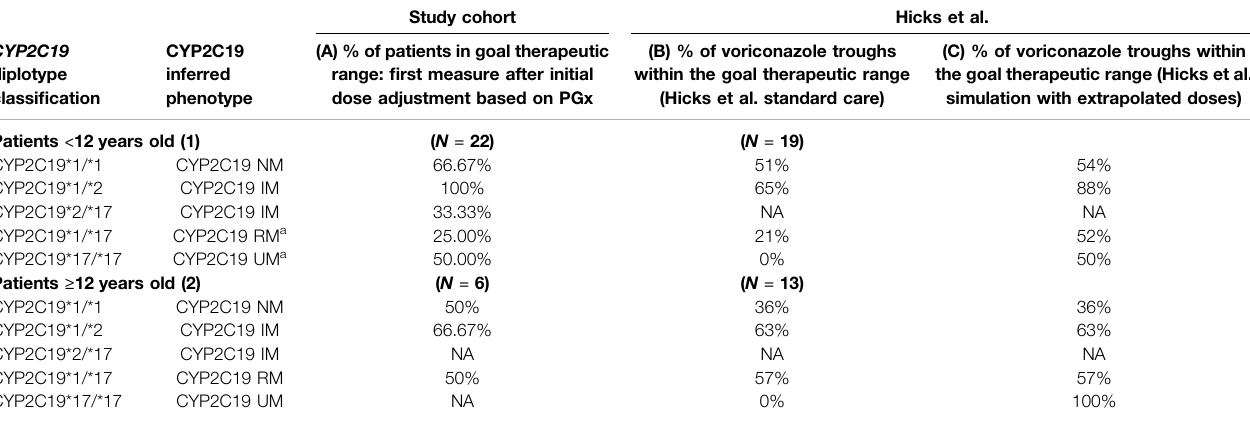
(C) % of voriconazole troughs within the goal therapeutic range (Hicks et